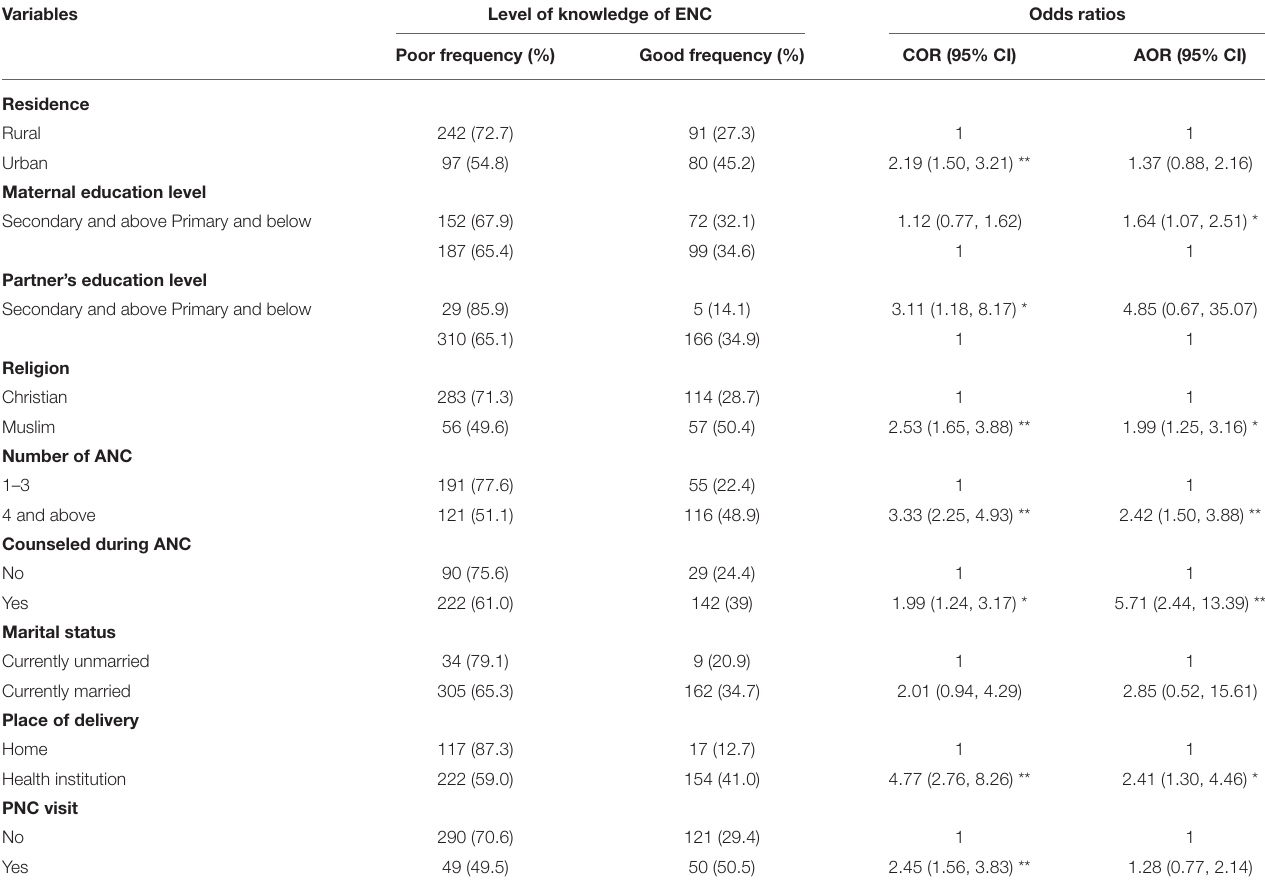
TABLE 4 | Bivariate and multivariate logistic regression for determinants of mothers’ knowledge of essential newborn care in Chole woreda, Ethiopia in 2019 ( n = 510).